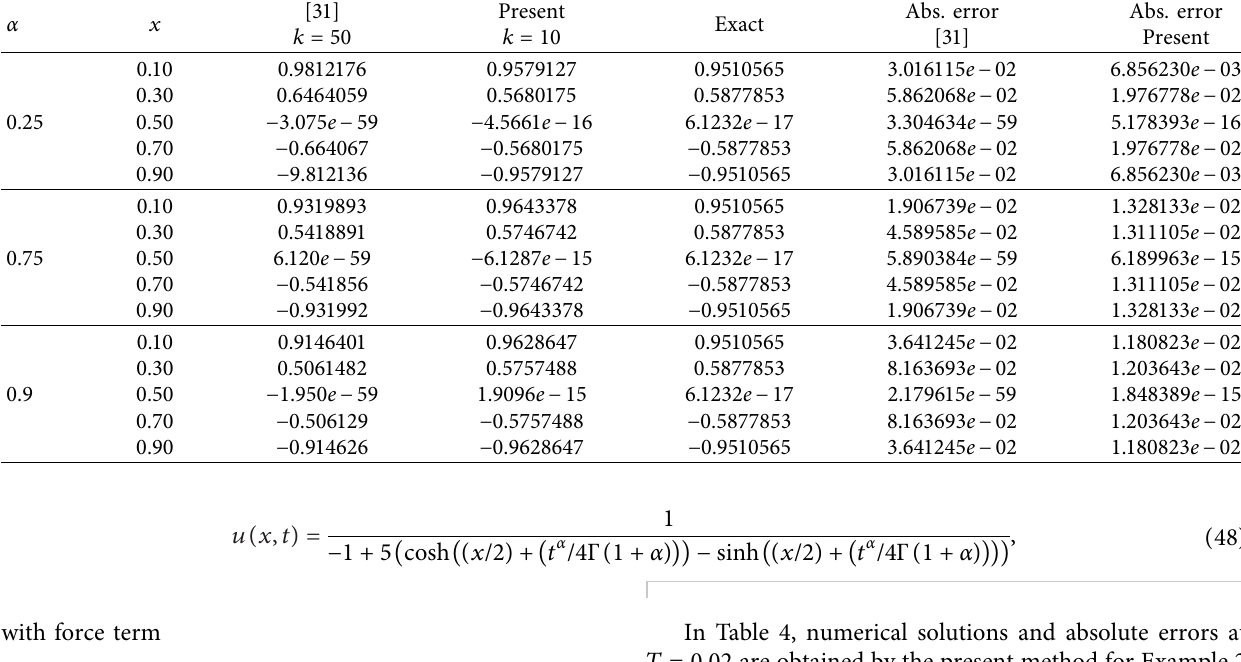
Table 2: Results of Example 1 at T � 1 for h � 0 .